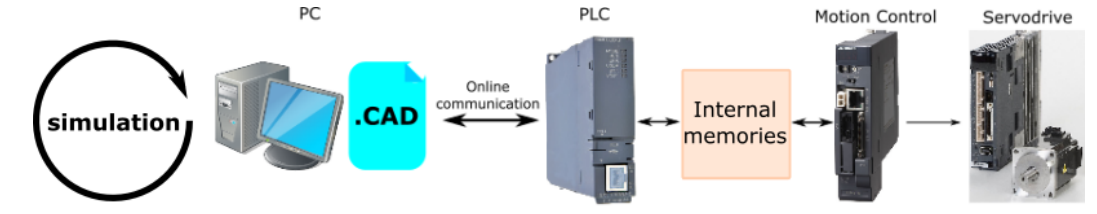
Figure 11. Control workflow and